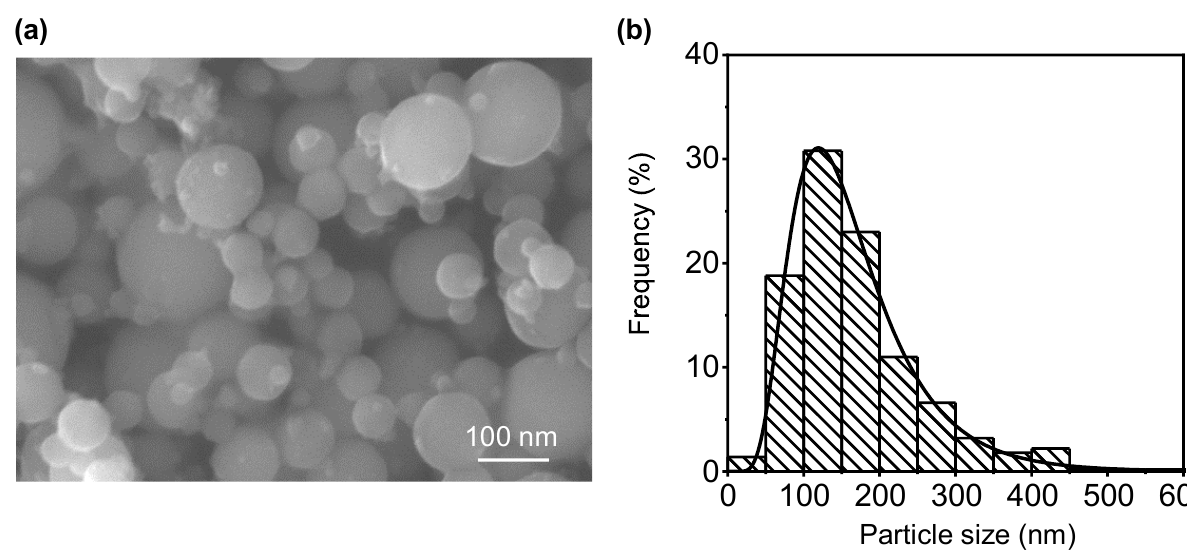
Figure 1. ( a ) FE-SEM image of Al nanopowder prepared by LO-ITP process and ( b ) histogram of Al particle size distribu- tion.